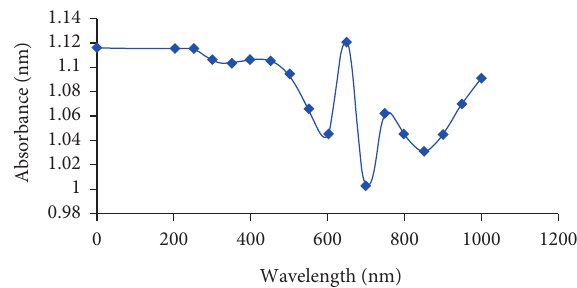
Figure 4: Absorbance and wavelength variation for the NRHA using an ultraviolet-visible spectrophotometer at 25 ° C.